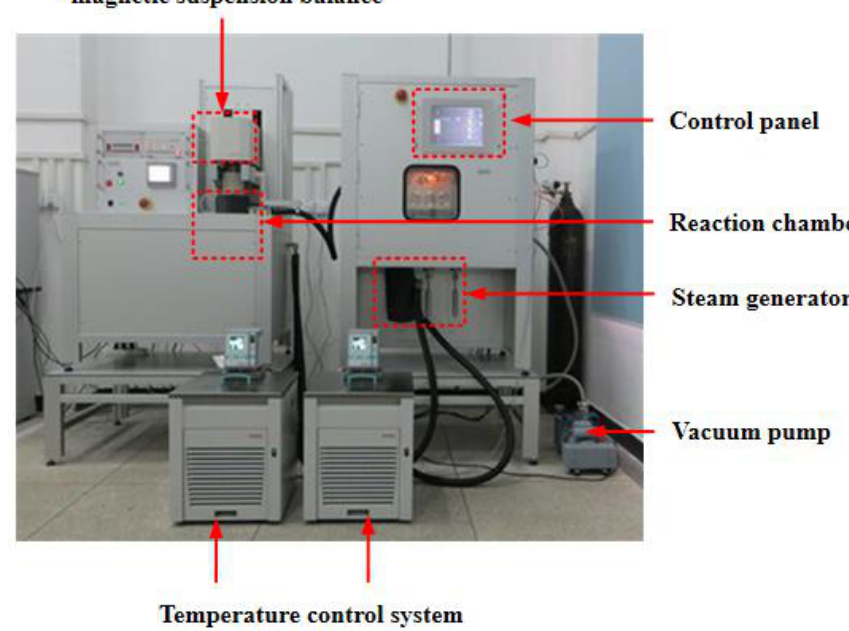
Figure 7. Gravimetric sorption analyser.